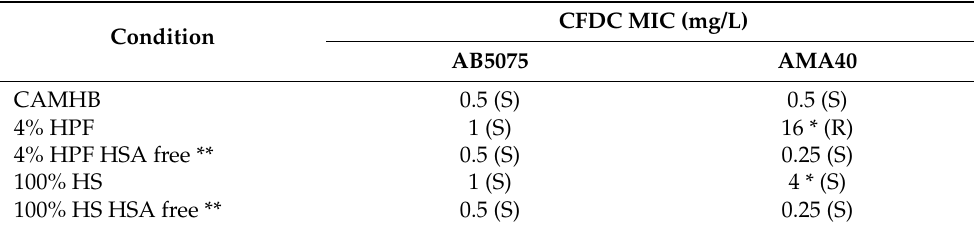
Table 1. Minimal inhibitory concentrations (MICs) of cefiderocol (CFDC) for the CRAB AB5075 and AMA40 strains, calculated using CFDC MTS strips (Liofilchem S.r.l., Italy) on iron-depleted CAMHA (cation-adjusted Mueller Hinton agar) and the different conditions tested. CFDC MIC (mg/L) Condition AB5075 AMA40 CAMHB 0.5 (S) 0.5 (S) 4% HPF 1 (S) 16 * (R) 4% HPF HSA free ** 0.5 (S) 0.25 (S) 100% HS 1 (S) 4 * (S) 0.5 (S) 0.25